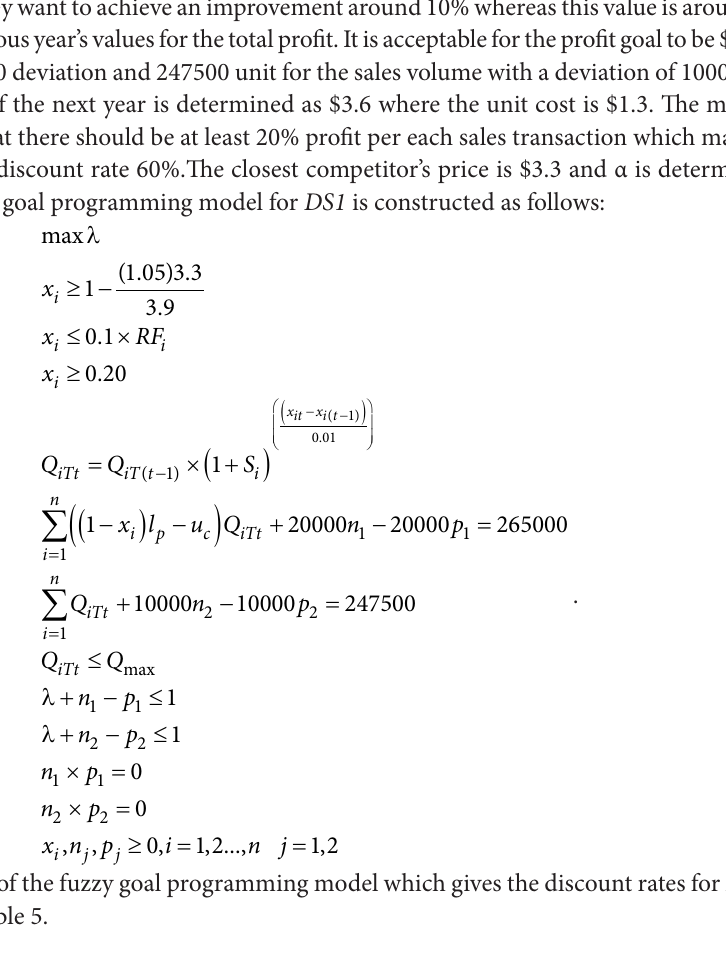
Table 5. Discount rates for DS1 at time period